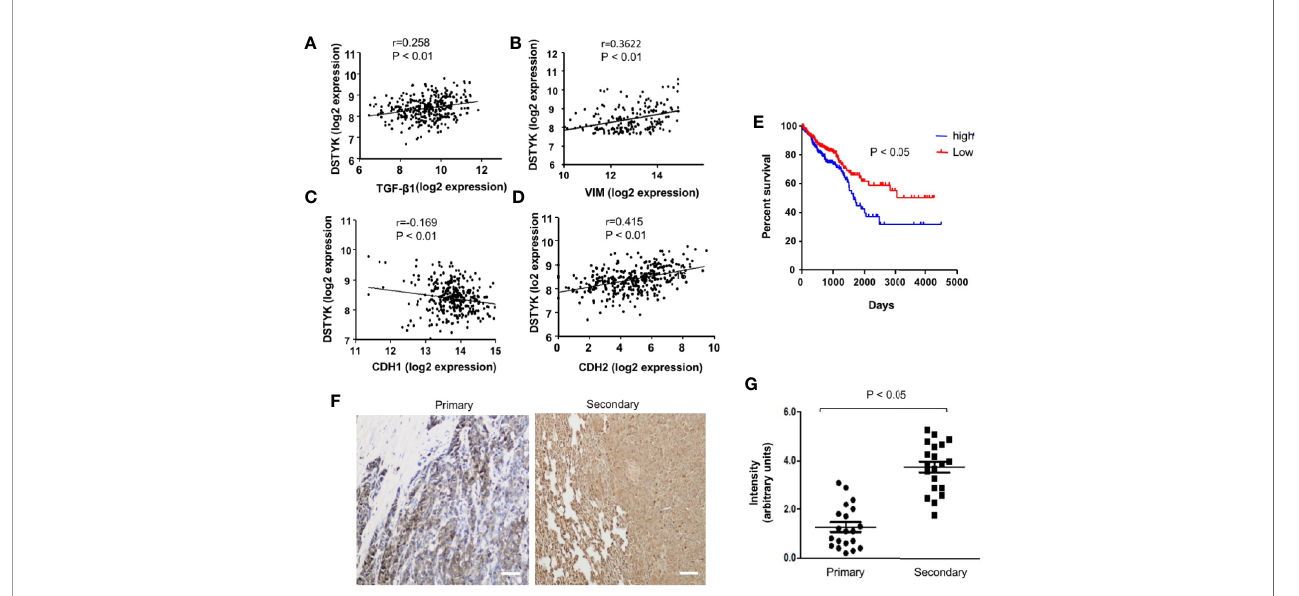
FIGURE 1 | DSTYK is associated with the metastasis of human colorectal cancer. (A) Scatter plot showing the correlation between the mRNA levels of DSTYK and TGF- b , (B) DSTYK and vimentin (VIM), (C) DSTYK and E-cadherin (CDH1), and (D) DSTYK and N-cadherin (CDH2) in the human TCGA colon cancer database. (E) Kaplan-Meier curve assessing the correlation between DSTYK expression and patients ’ survival rate obtained from 652 patients in The Gene Expression Omnibus (GEO) database. Blue line represents metastatic colorectal cancer patients with high DSTYK expression (n=154) and the red line represents patients with low DSTYK expression (n=498) in the GSE 17538 dataset. SPSS repeated measures, general linear model. (F) Representative images of human colorectal primary tumors and secondary tumors subjected to immunohistochemical (IHC) analysis with DSTYK antibody. Images were taken after IHC staining. Scalebar, 50 µm. (G) Quanti fi cation ofthe staining signalsfromIHC analyses of DSTYK in both primary and secondarytumortissues. Data are presented as means± SEM.for